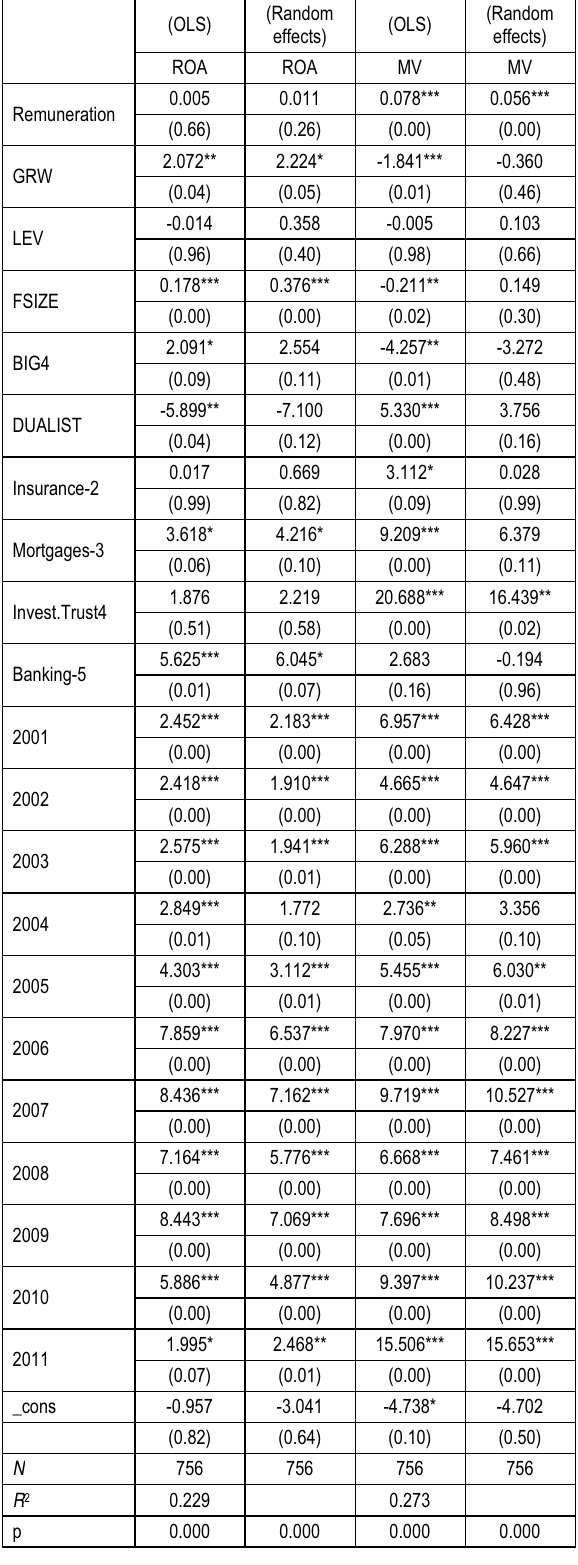
Table 6. ROA and MV regression